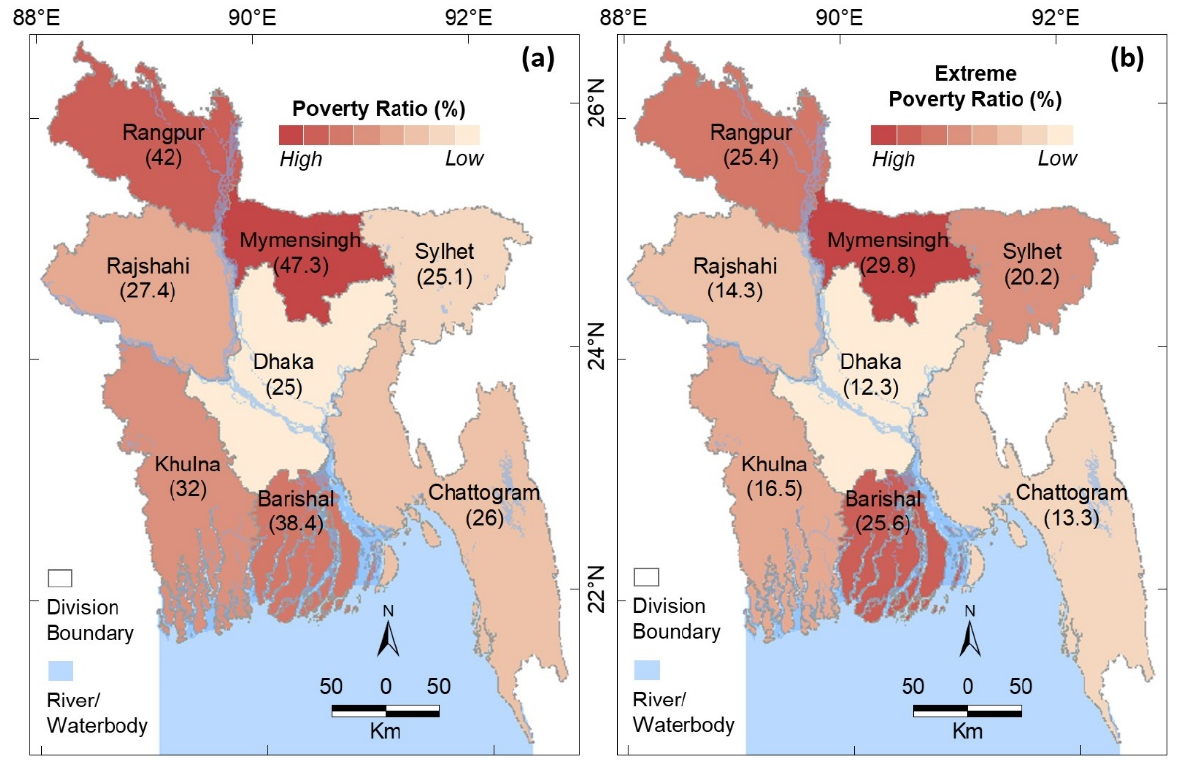
Figure 7. Ratios of the population living in ( a ) poverty and ( b ) extreme poverty in the divisions of Bangladesh. Absolute values are given brackets for each division.